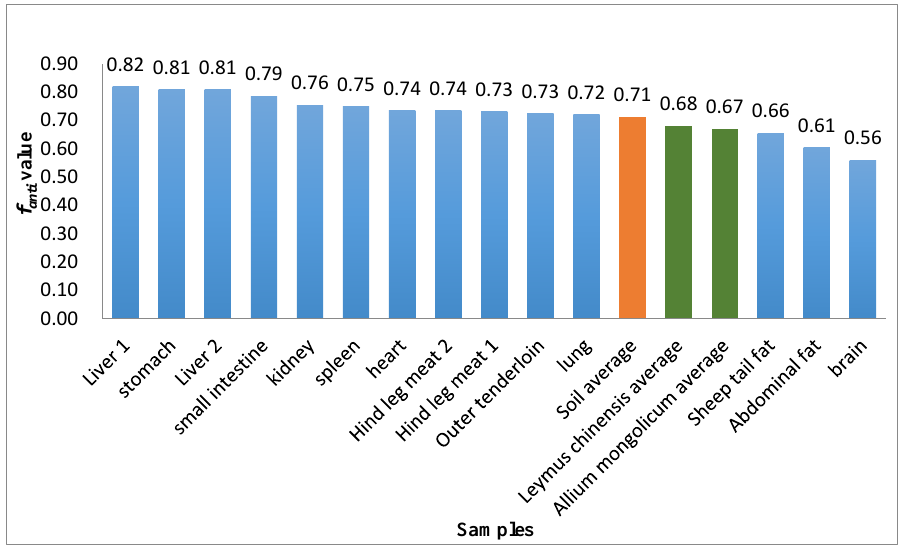
Figure 5. f anti values for various sheep tissues, plants, and soil.